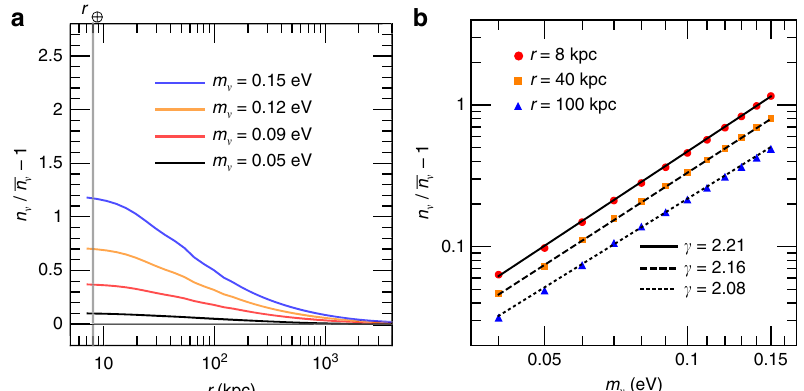
Fig. 1 Clustering of thermal relic neutrinos in the MW. a The neutrino contrast δ ν ¼ n ν = n ν (cid:2) 1 as a function of the distance r to the galactic center of MW. The location of the Earth r ⊕ = 8 kpc is indicated by a gray vertical line. b The neutrino contrast δ ν as a function of the neutrino mass m ν for three different distances of r to the galactic center of MW. Both the horizontal and vertical axes are in logarithmic scale. Scatter points are the N-one-body simulation results. Each set of scatter points is well fi tted by a power-law function δ ν / m γ